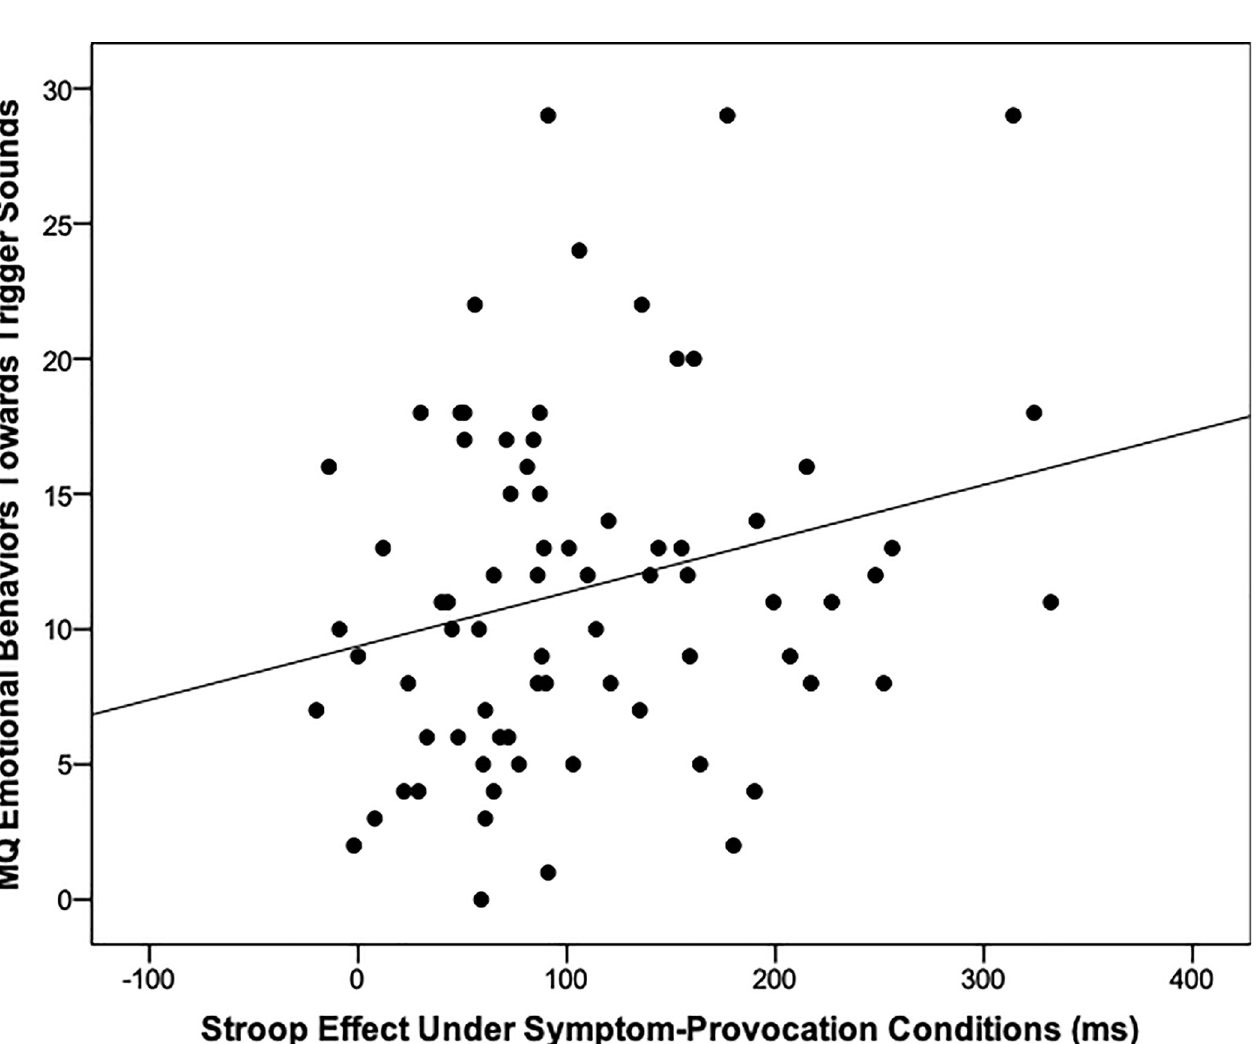
Fig 2. Pearson correlation between Misophonia Questionnaire (MQ) emotional behaviors to trigger sounds and the Stroop effect while exposed to the misophonia trigger sounds.